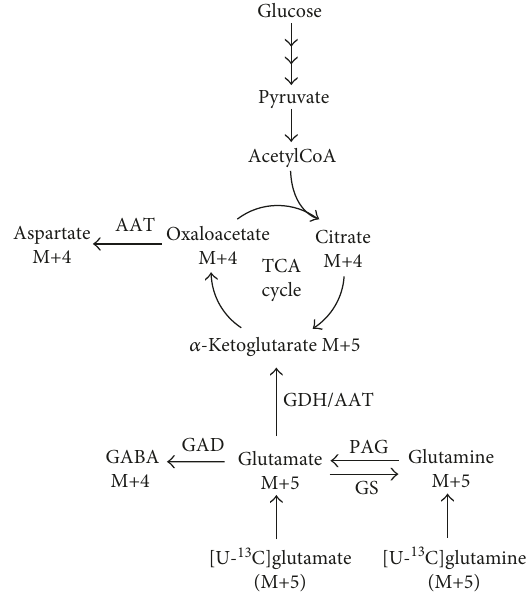
Figure 1: Cartoon illustrating 13 C labeling patterns from [U- 13 C]glutamate and [U- 13 C]glutamine metabolism. Glutamate M+5 can be converted into glutamine M+5 or GABA M+4 through glutamine synthetase (GS) or glutamate decarboxylase (GAD) activity, respectively. Glutamine M+5 can likewise be converted into glutamate M+5 through the action of phosphate- activated glutaminase (PAG). Additionally, glutamate M+5 can be converted into α -ketoglutarate M+5 by activity of either glutamate dehydrogenase (GDH) or aspartate aminotransferase (AAT) and be introduced into the TCA cycle. α -Ketoglutarate M+5 can be metabolized in the TCA cycle, giving rise to 13 C labeling in all TCA cycle intermediates. Aspartate is in close equilibrium with oxaloacetate trough AAT, giving rise to aspartate M+4